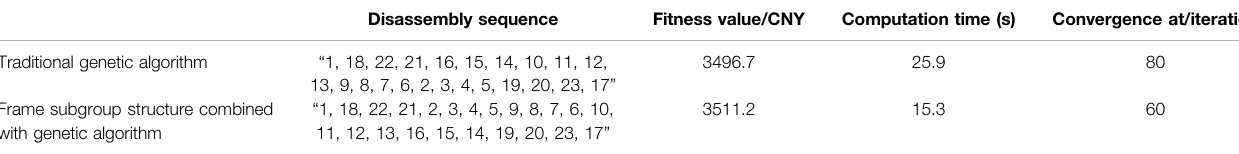
TABLE 3 | Part of the results of the two methods.